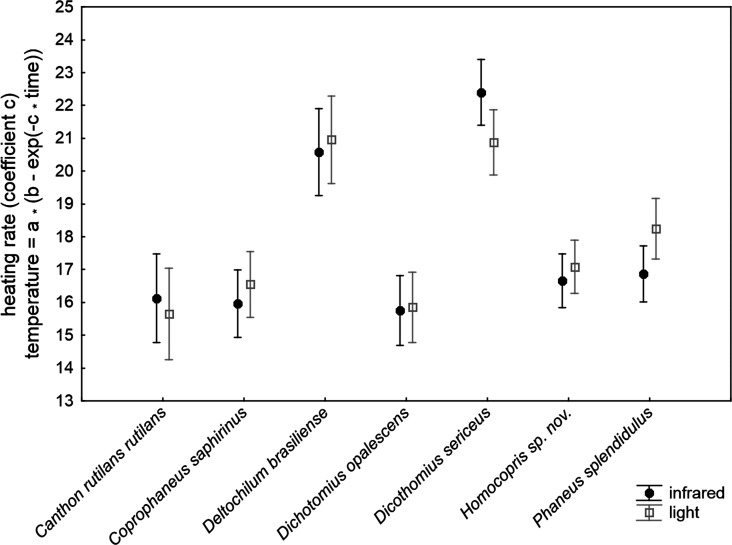
Mean ± one standard error of heating rates at the beginning of the heating trials in seven dung beetles (Scarabaeinae) under two sources of radiation: infrared radiation (infrared) and luminous radiation (light) resembling the electromagnetic spectrum of sun radiation.The values presented are adjusted means after controlling for the effect of the three covariates included in the ANCOVA model of Table 3 (control temperature, animal volume and weight per volume unit).